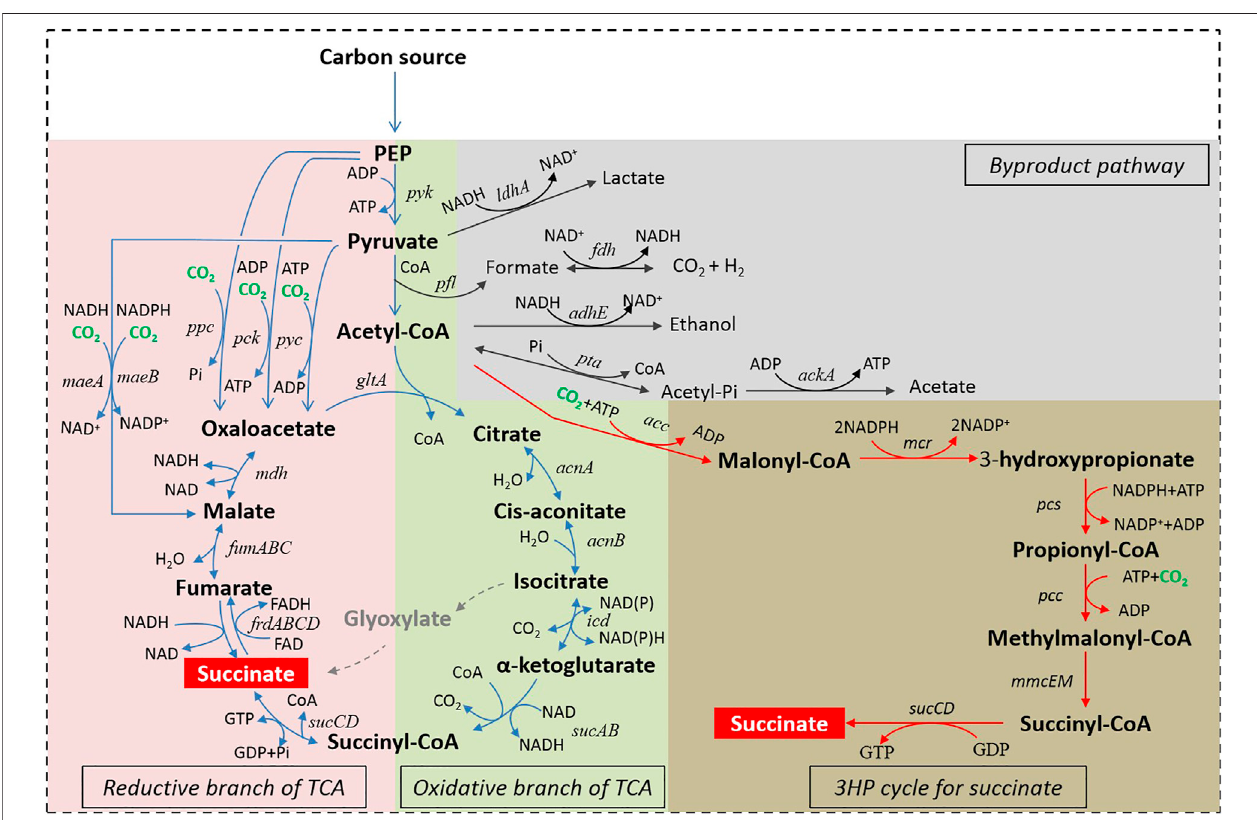
FIGURE 1 | Succinic acid production biosynthetic pathways. Abbreviations: PEP, Phosphoenolpyruvic acid; ldhA , lactic dehydrogenase; p fl , pyruvate formate lyase; fdh , formate dehydrogenase; adhE , alcohol dehydrogenase; pta , phosphotransacetylase; ackA , acetate kinase; gltA , citrate synthetase; acnAB , aconitase; icd , isocitrate dehydrogenase; sucABCD , succinyl-CoA synthetase; frdABCD , succinate dehydrogenase; fumABC , fumarate hydratase; mdh , malate dehydrogenase; ppc , PEP carboxylase; pck, PEP carboxykinase; pyc , pyruvate carboxylase; pyk , pyruvate kinase; maeAB , malic enzyme; acc , acetyl-CoA carboxylase; mcr , malonyl- CoA reductase; pcc , propionyl-CoA carboxylase; pcs , propionyl-CoA synthase; mmcEM , methylmalonyl-CoA epimerase and